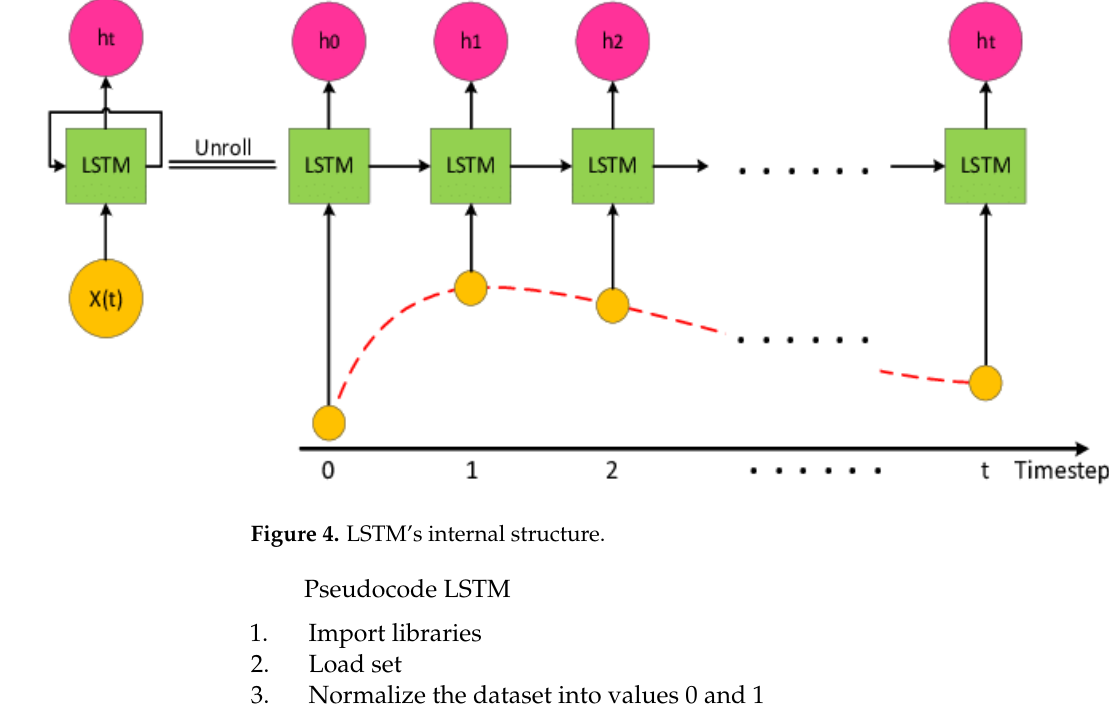
Figure 4. LSTM’s internal structure.